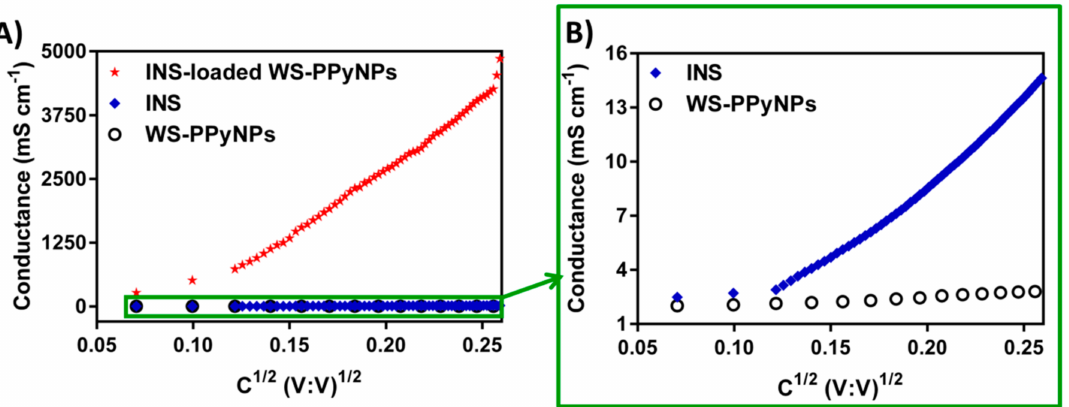
Figure 3. Conductivity assessment of INS-loaded WS-PPyNPs. ( A ) Plots of conductivity, versus square root concentration in water at 25 ◦ C, WS-PPyNPs (blank circle), INS (blue diamond), and INS-loaded WS-PPyNPs (red asterisk). ( B ) High- resolution conductometric curves of WS-PPyNPs and